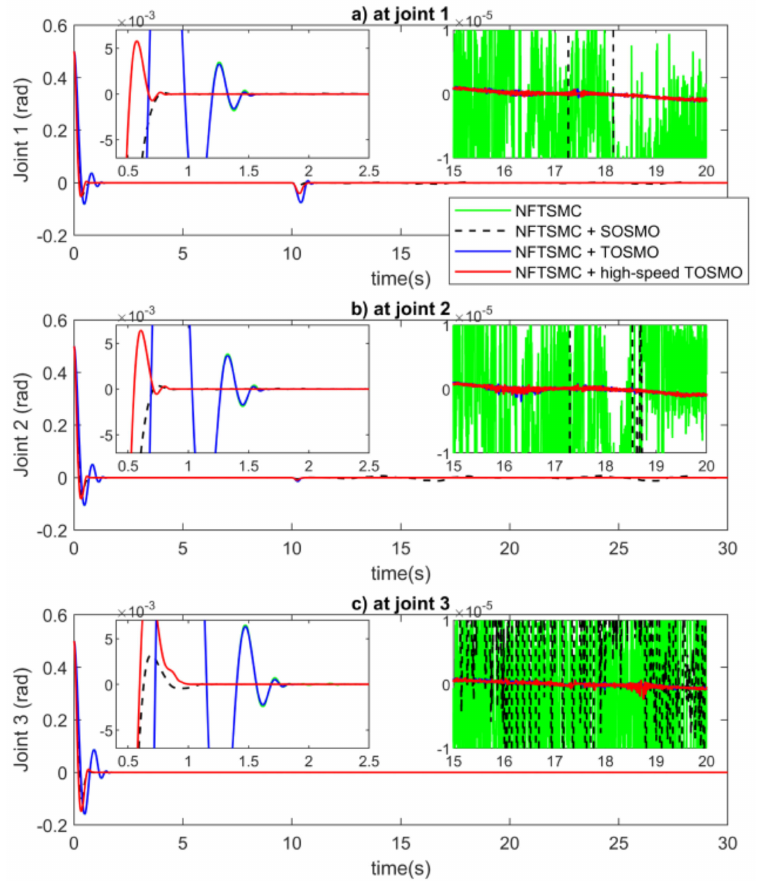
Figure 6. Comparison of tracking errors among controllers at ( a ) joint 1, ( b ) joint 2 and ( c ) joint